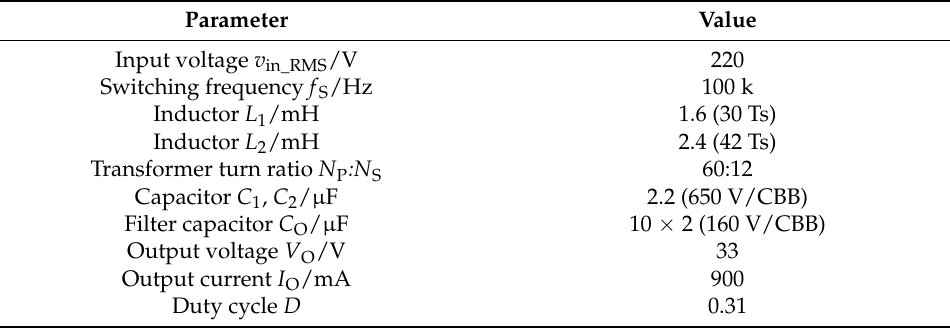
Table 1. The key parameters of the proposed driver. Parameter